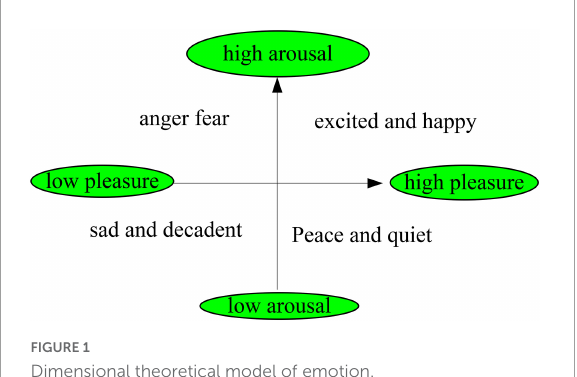
FIGURE1 Dimensional theoretical model of